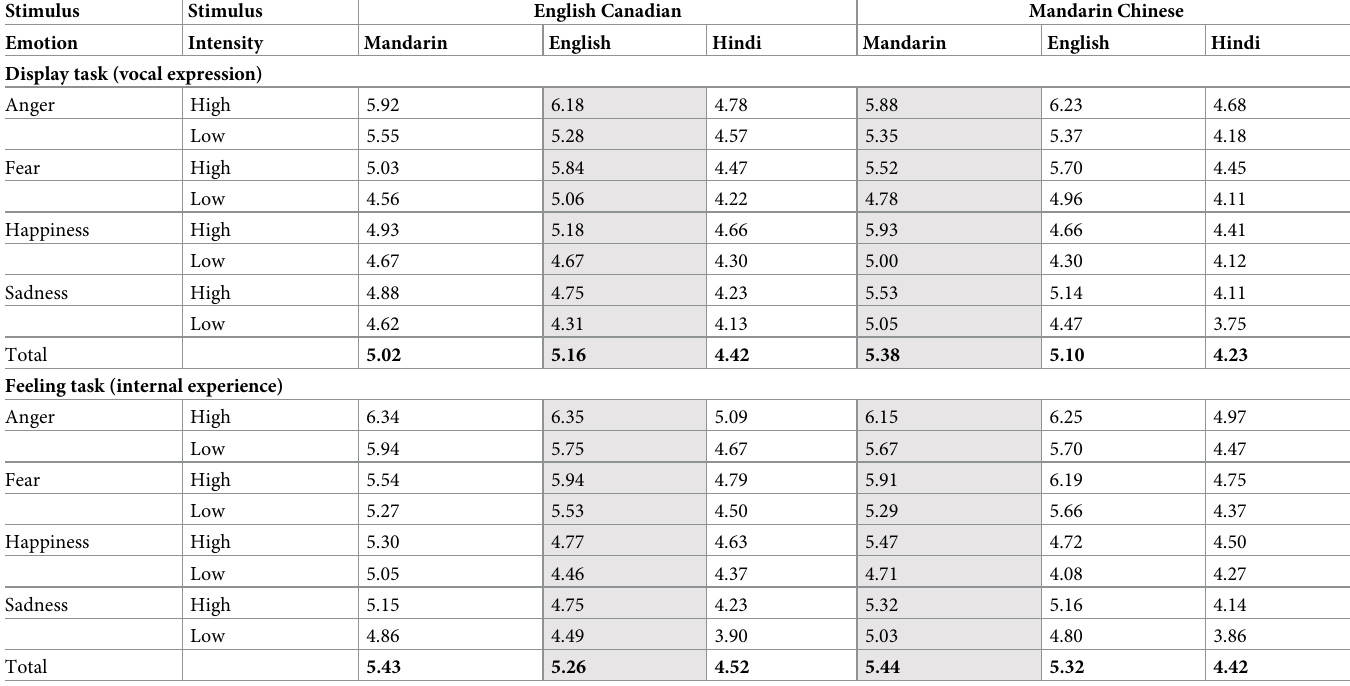
Table 3. Average intensity ratings when judging the vocal expression (display task) and the speaker’s internal experience (feeling task), for Canadian and Chinese participants.